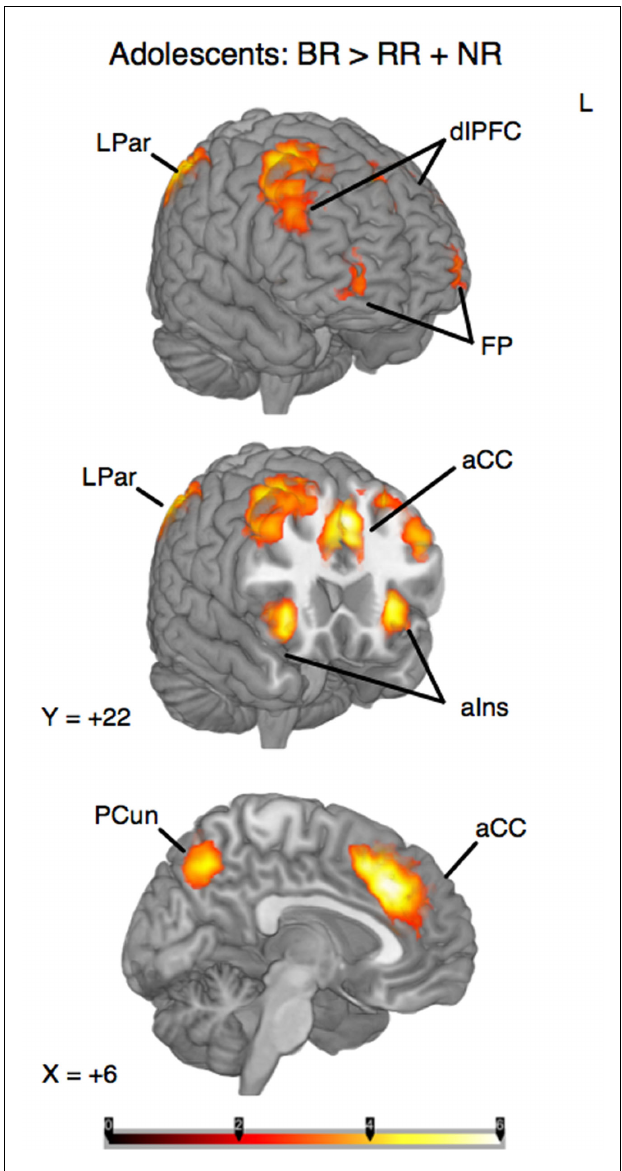
FIGURE 2 |Whole-brain analysis of decisions involving behavioral risk (BR) greater than reward risk (RR) and no risk (NR) conditions in adolescents. Behavioral risk elicited patterned activation in the insula, frontal poles (FP) and middle frontal gyrus, anterior cingulate (aCC), superior frontal gyrus, medial prefrontal cortex, precuneus (pCun), and Inferior Parietal Lobule.Within these significant cluster of regions also included the dorsolateral prefrontal cortex (dlPFC), anterior insula (alns), and lateral parietal regions (LPar).